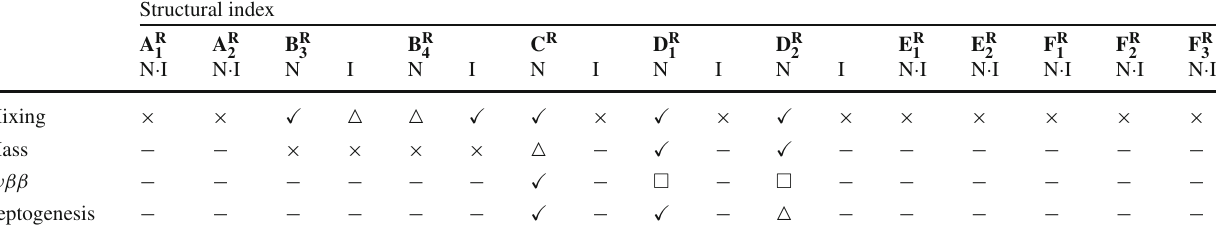
Table 6 The consistency between the models with the TZM structure and the experimental constraints, namely the neutrino mixing angles, sum of the neutrino masses and effective Majorana neutrino mass. We also show the possibility to generate the correct sign of the baryon asymmetry. “N” and “I” represent the NO and IO, respectively. “ (cid:4) ” and “ × ” represent whether models are consistent with the experimental constraints or not. “ (cid:14) ” means that, in the column of mixing, the models